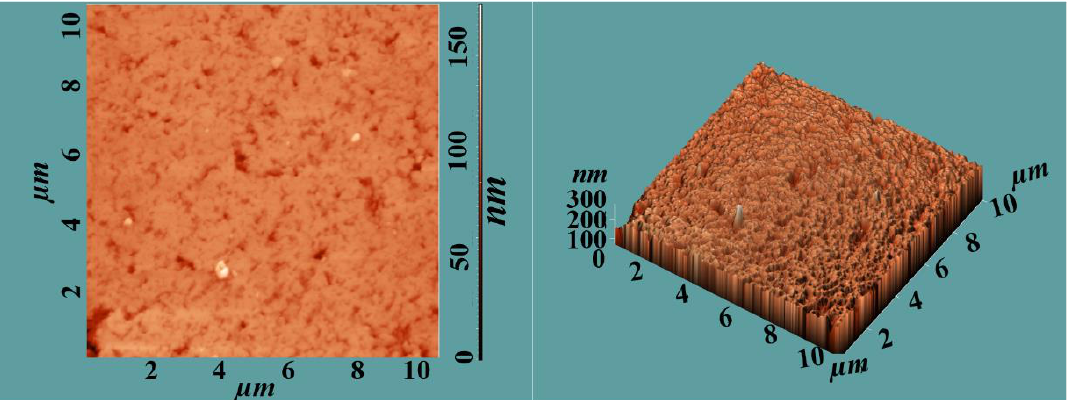
Figure 20. Atomic force micrograph 2D views (left) and respective 3D views (right) of recycled [V IV O(acac)L 1 ]@PS ( 3 ).